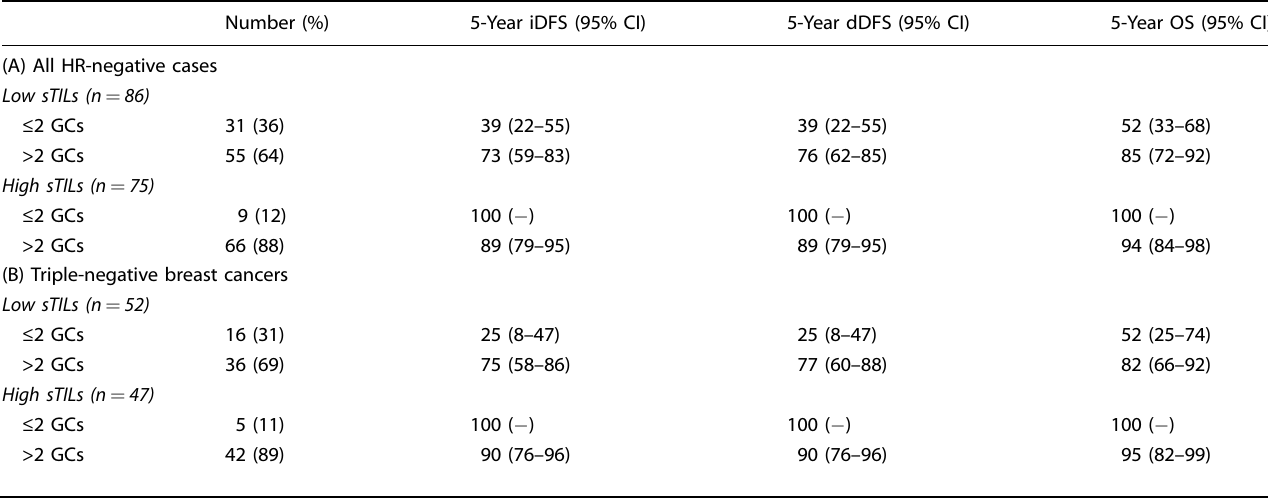
Table 4. 5-year outcome for patients by TILs in primary cancers & germinal center subgroups. A) All HR-negative cases. B) Triple-negative breast